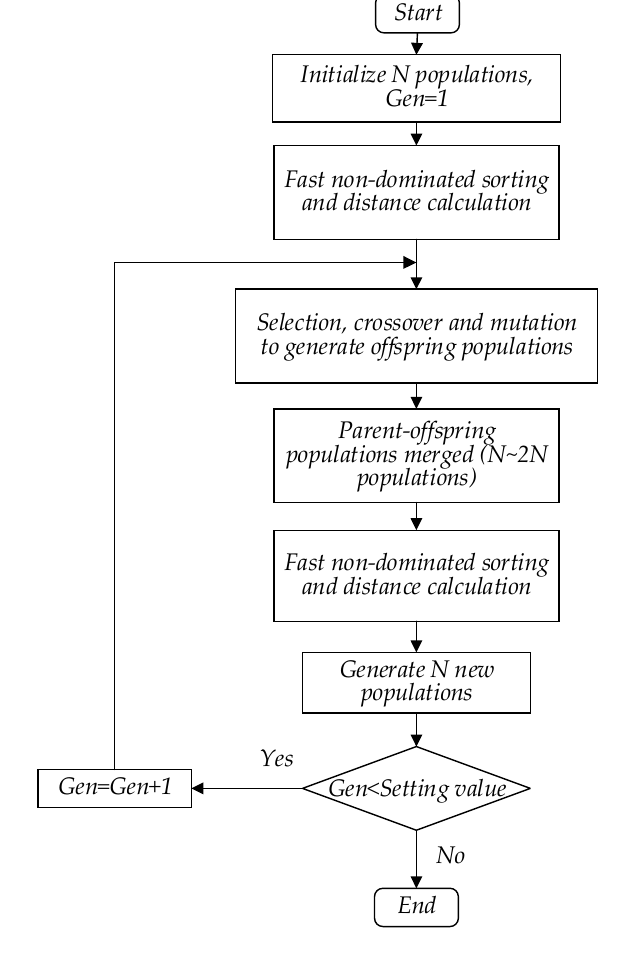
Figure 6. NSGA-II algorithm flowchart.